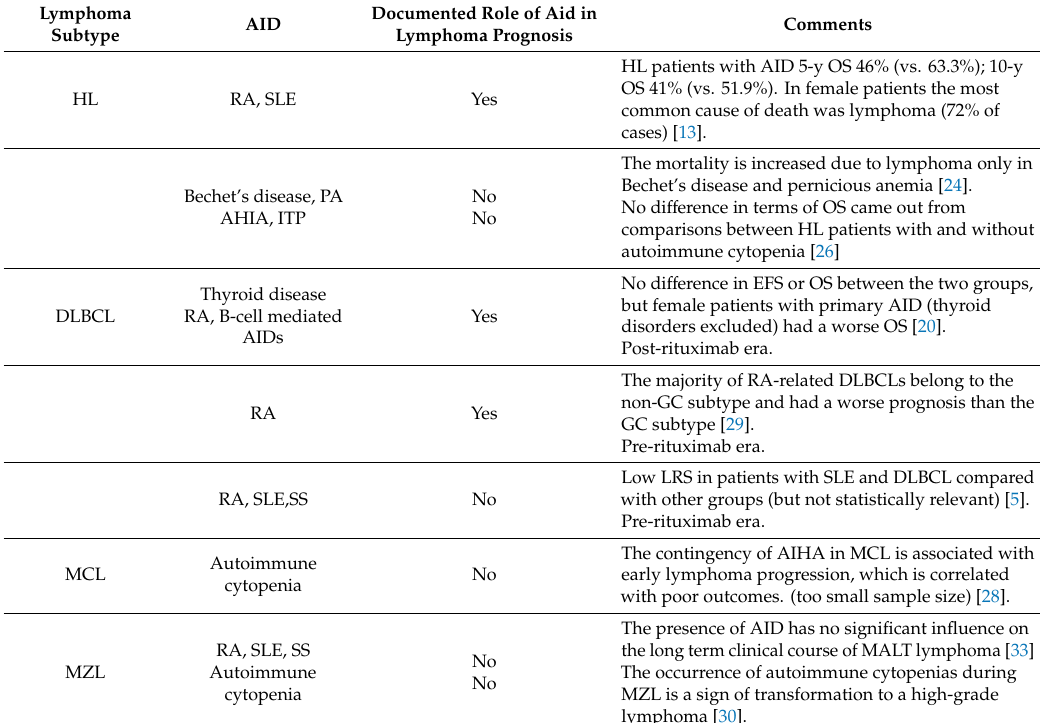
Table 1. AID role in the prognosis of lymphoma by